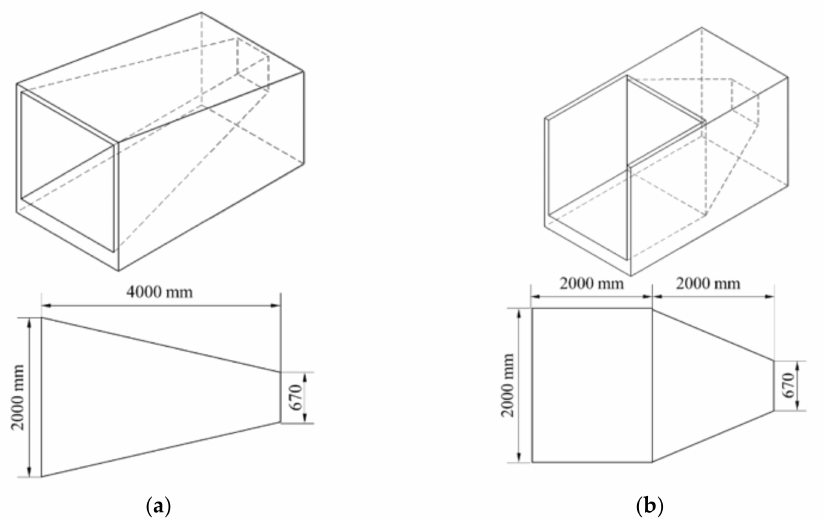
Figure 2. ( a ) First duct design with taper configuration from the inlet to the outlet, dimension in mm. ( b ) Second duct design with initial straight open roof duct, followed by taper configuration, with dimension in mm. Both designs were tested in [34] by means of a numerical approach.